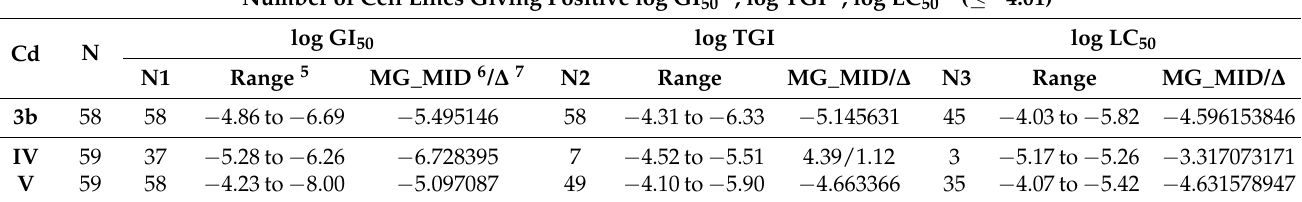
Table 5. Overview of the results of the in vitro anticancer activity for compound 3b in comparison with analogs IV and V 1